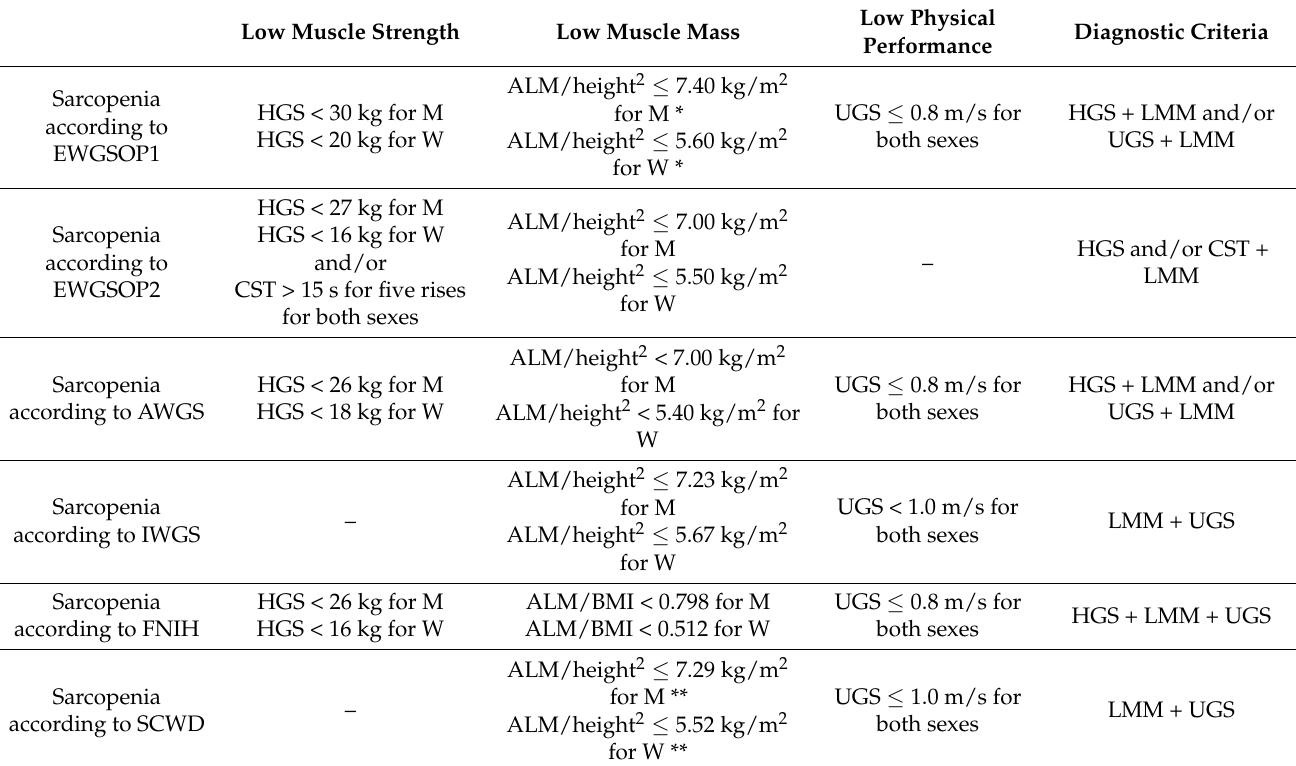
Table 2. Six sets of international diagnostic criteria for